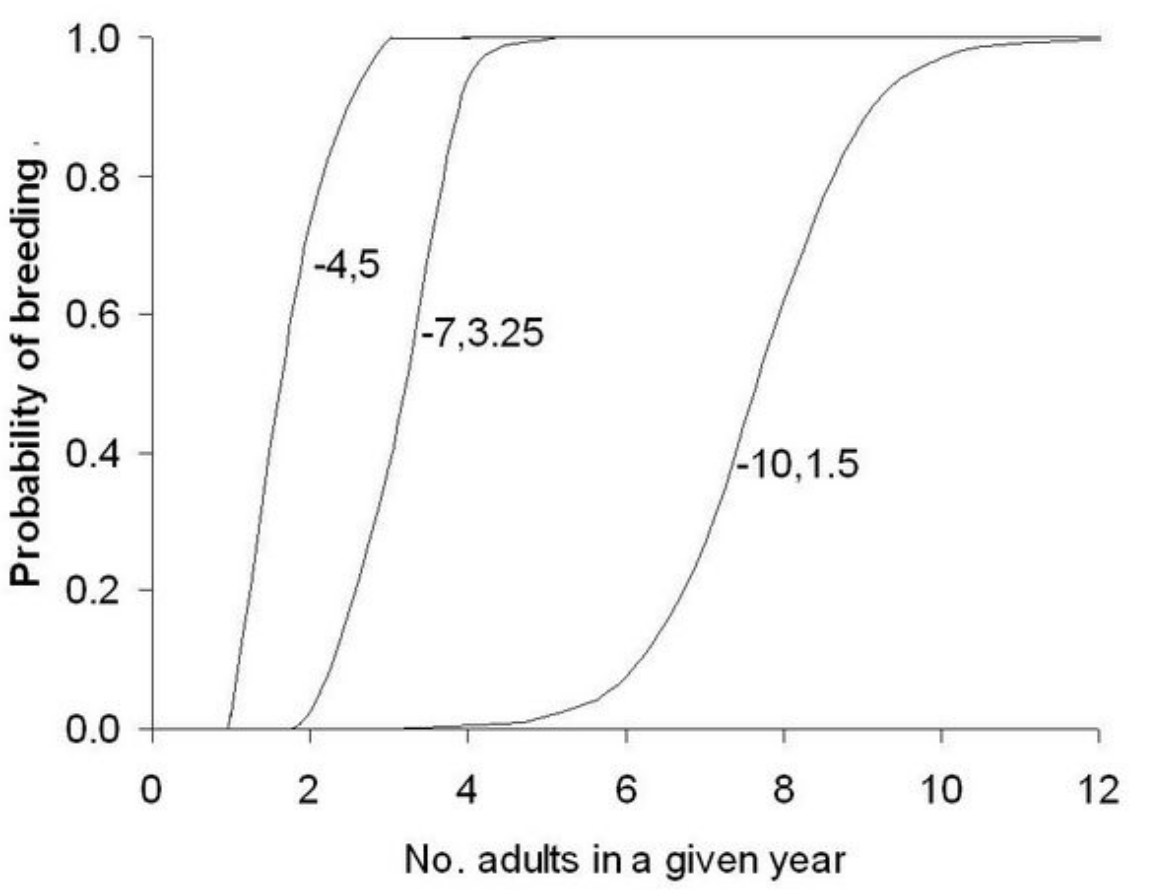
Fig. 2. Range of Allee effects used in a perturbation analysis of a stage-based, discrete, stochastic population viability analysis for large woodpeckers. The intercept (ß between current population size and probability of breeding decreases as the Allee effect becomes stronger. The intercept and slope are shown to the right of each curve (ß exceeding 2, 5, and 11 ensure that all individuals in the population will attempt to breed under the three scenarios,